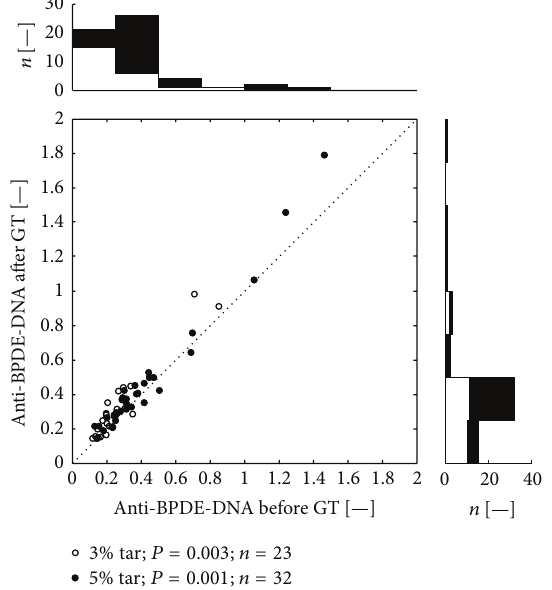
Figure 1: Distribution of values of anti-BPDE-DNA (all patients). Legend: Scatter plot depicts anti-BPDE-DNA values before and after the GT therapy. All together 55 dots represent 110 measurements, each dot belongs to a one patient.